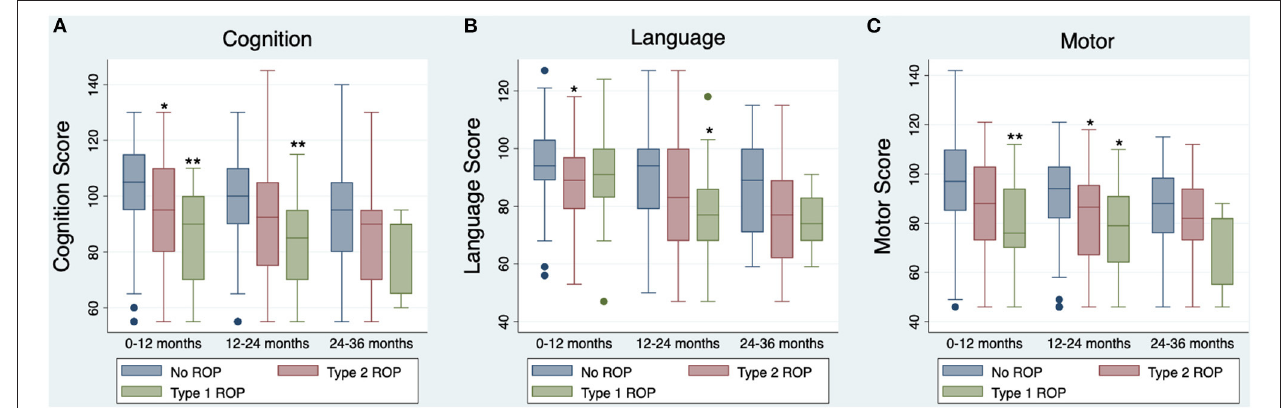
FIGURE 1 | Boxplots of Bayley-III Neurodevelopmental Composite Scores, by univariable analysis (uncorrected for covariates). Boxplot lines and rectangles indicate the median and 1.5 × interquartile range below the first quartile or above the third quartile. The navy circles represent scores falling outside of that range, though all scores were included in analyses. Asterisks represent significant differences in Bayley-III neurodevelopmental scores between infants without ROP and infants with type 1 or type 2 ROP as measured by post-hoc analyses, * p < 0.05, ** p < 0.01. (A) Cognition scores at 0–12 months ( n = 191), 12–24 months ( n = 142), and 24–36 months ( n = 59) for infants with no ROP (blue), type 2 ROP (red), or type 1 ROP (green). (B) Language scores at 0–12 months ( n = 191), 12–24 months ( n = 142), and 24–36 months ( n = 56) for infants with no ROP, type 2 ROP, or type 1 ROP. (C) Motor scores at 0–12 months ( n = 191), 12–24 months ( n = 142), and 24–36 months ( n = 59) for infants with no ROP, type 2 ROP, or type 1 ROP.